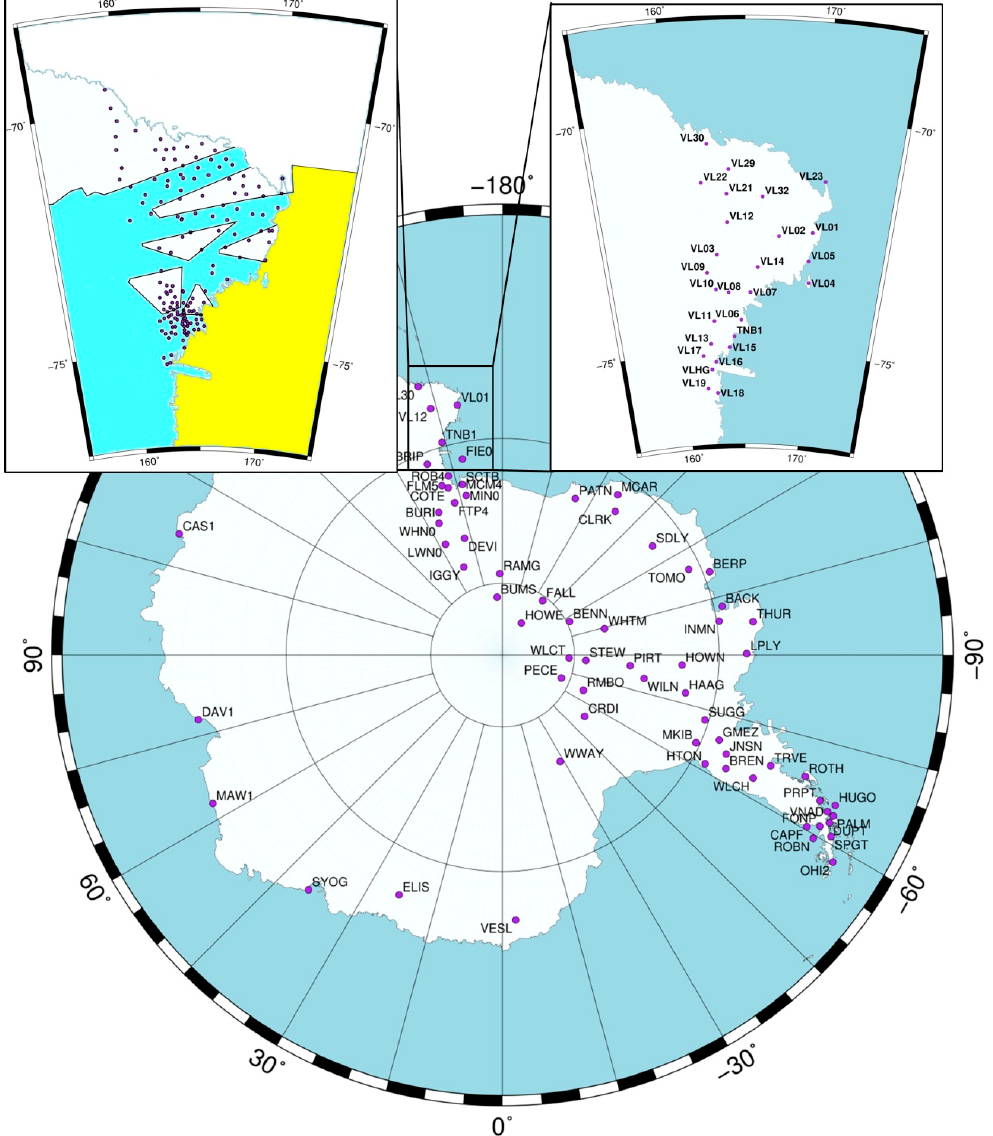
Figure 2. Overview over the location of Global Navigation Satellite System (GNSS) stations and gravity sites used in the present work. The top-left inset shows locations of terrestrial gravimetric measurements. The cyan color defines the area where British Antarctic Survey (BAS) airborne data are available [25]; the yellow color identifies an area covered with shipborne gravimetric data [20]; white color defines the areas not covered by airborne and shipborne data. The top-right inset depicts the Victoria Land Network for Deformation control (VLNDEF) network, surveyed in the frame of the Italian National Program for Antarctic Research (PNRA) over 20 years.